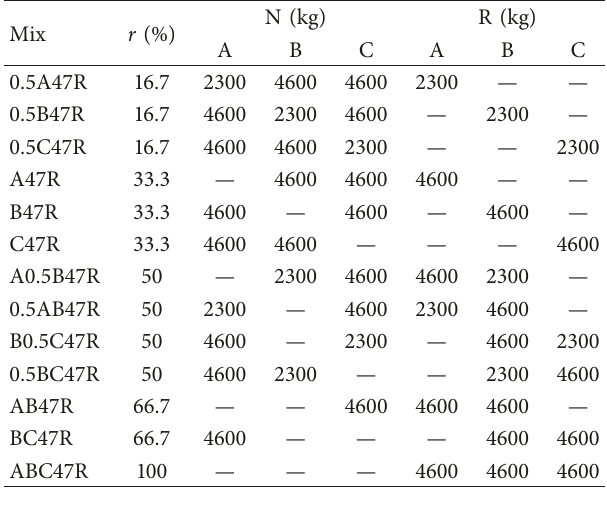
Table 3: Coarse aggregate of recycled aggregate concrete.